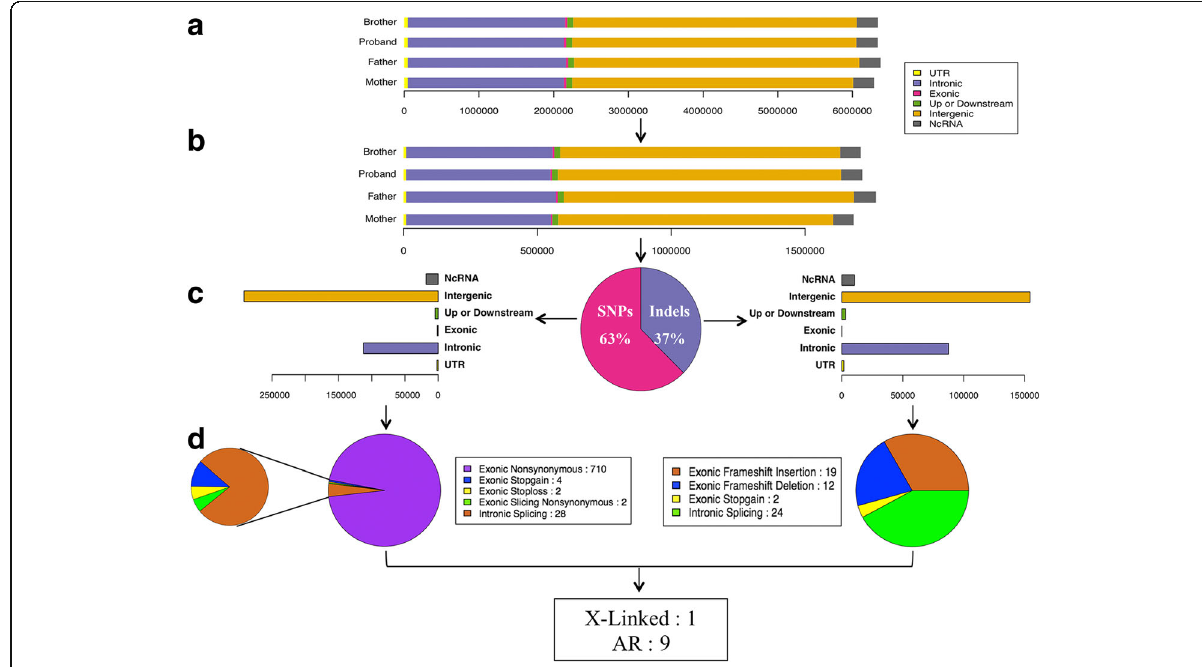
Fig. 2 Illustrates the pipeline of whole genome data analysis. a The count distribution of variants (SNVs and InDels) from WGS clean data for each individual in the family. The variants were classified into distinct classes according to the genomic regions. b The count distribution of variants